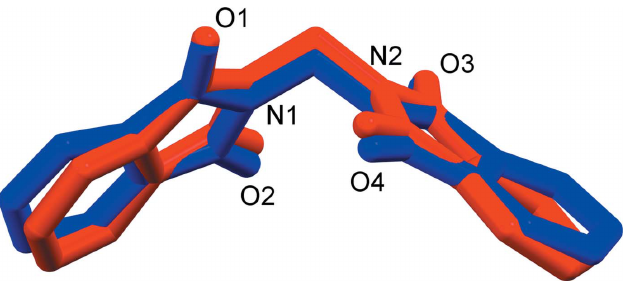
Figure 2 An overlay diagram for the molecules of 1 (cid:2) (red) and 1 (cid:3) (blue).